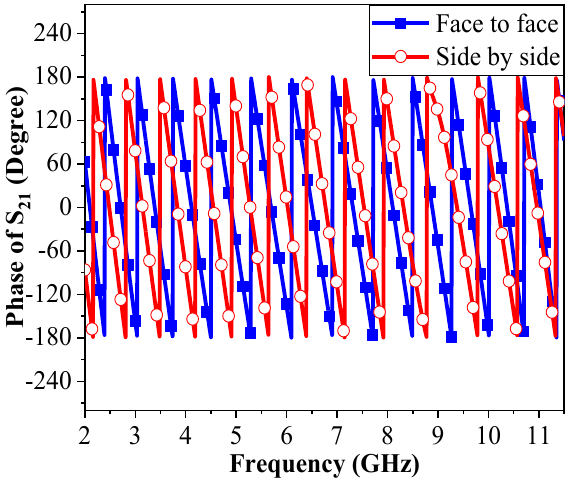
FIGURE 14. Simulated phase of S 21 in both configurations (Face-to-face and side-by-side). Fig. 13 indicates that the variation of group delay in the face- to-face mode does not exceed 0.5 ns, while in the side-by- side mode it is less than 1 ns over the operational bandwidth. As shown in fig. 14, in both modes: face-to-face and side-by- side, the phase of S 21 has linear variation over the working bandwidth. This is required for impulse radar systems, which need linear phase response and low